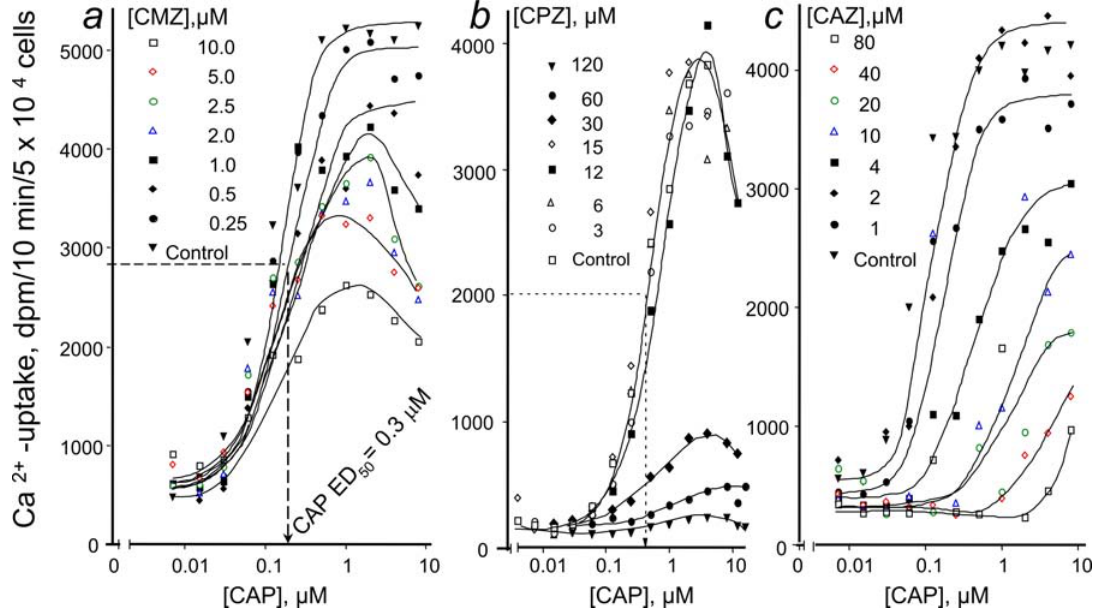
Figure 3. Kinetics of Ca 2 + -transport inhibition by calmidazolium (CMZ), chlorpromazine (CPZ) and capsazepine (CAZ) in TRPV1-NIH3T3 cells, induced by increasing concentrations of capsaicin. Increasing doses of calmidazolium decreased V max of Ca 2 + -transport, however, affinity of TRPV1 to capsaicin remained constant, as indicated. Likewise, chlorpromazine showed distinctive, non-competitive inhibition kinetics, similar to that determined to calmidazolium, consistent with a channel blocking mechanism on TRPV1. In contrast to calmidazolium and chlorpromazine, capsazepine, a bona fide vanilloid antagonist shifted the capsaicin dose-response curves right, however, above 1 m M behaved as a mixed kinetics inhibitor, also decreased V max . Experiments were repeated two additional times in duplicates with similar